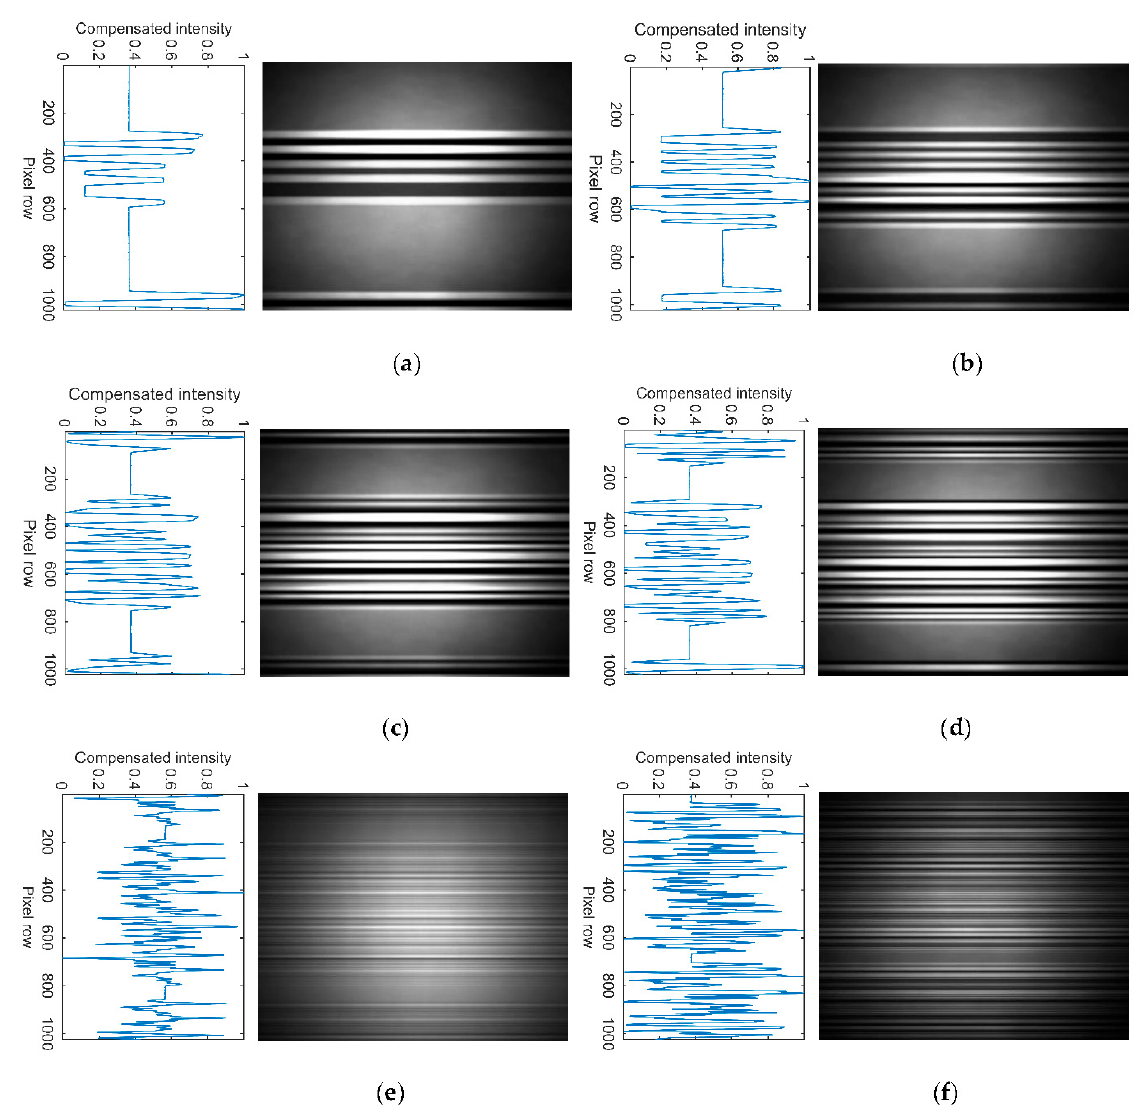
Figure 7. Examples of the frame acquisition based on CIS for CP 4-PAM and f Tx of: ( a ) 220 Hz, ( b ) 320 Hz, ( c ) 420 Hz, ( d ) 520 Hz, ( e ) 1120 Hz, and ( f ) 1520 Hz. Table 3. Results with R f of 30 fps and CIS width of 1024 px.